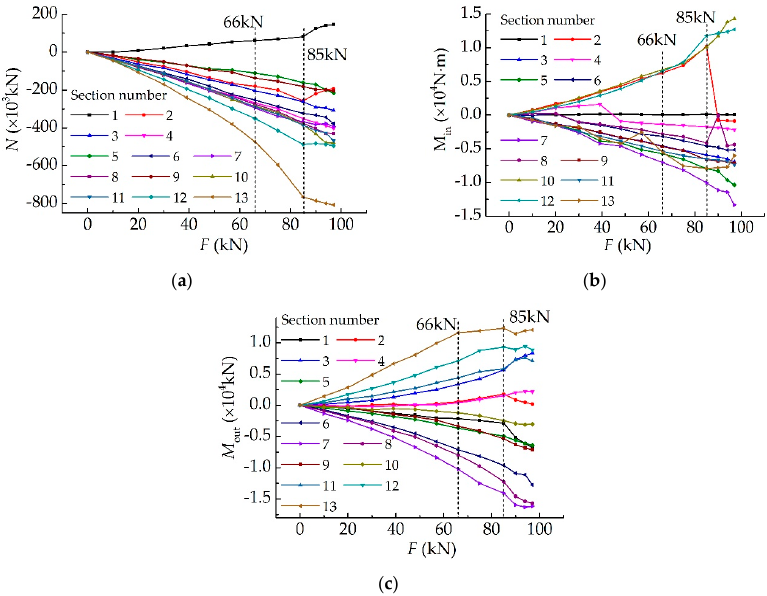
Figure 10 . The stressing state submodes for internal forces of the arch: ( a ) N - F curves; ( b ) M in - F curves; ( c ) M out - F curves.